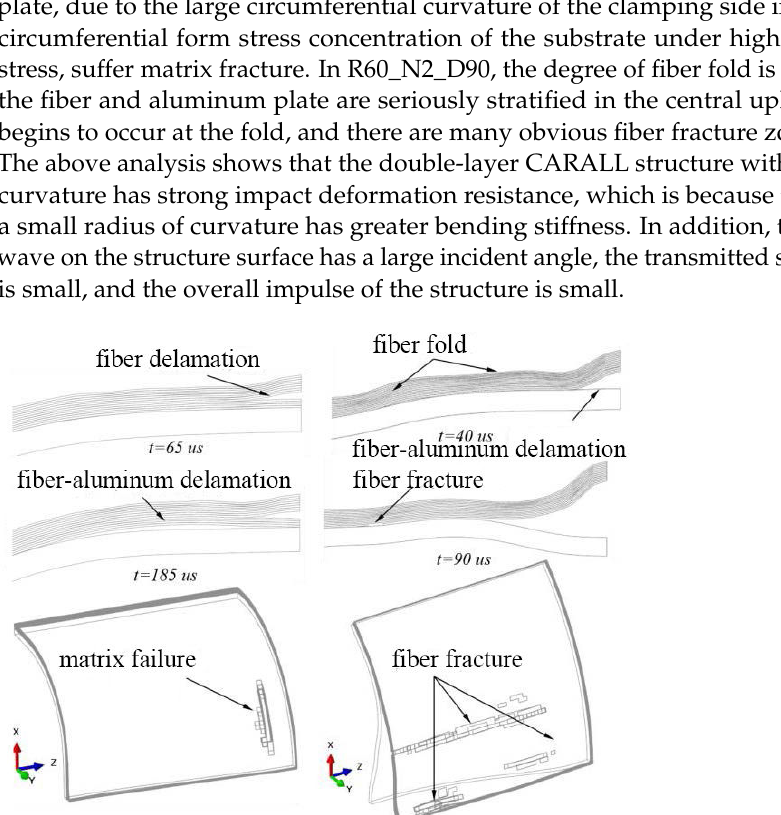
Figure 15. Failure mode of fiber with a large radius of curvature.